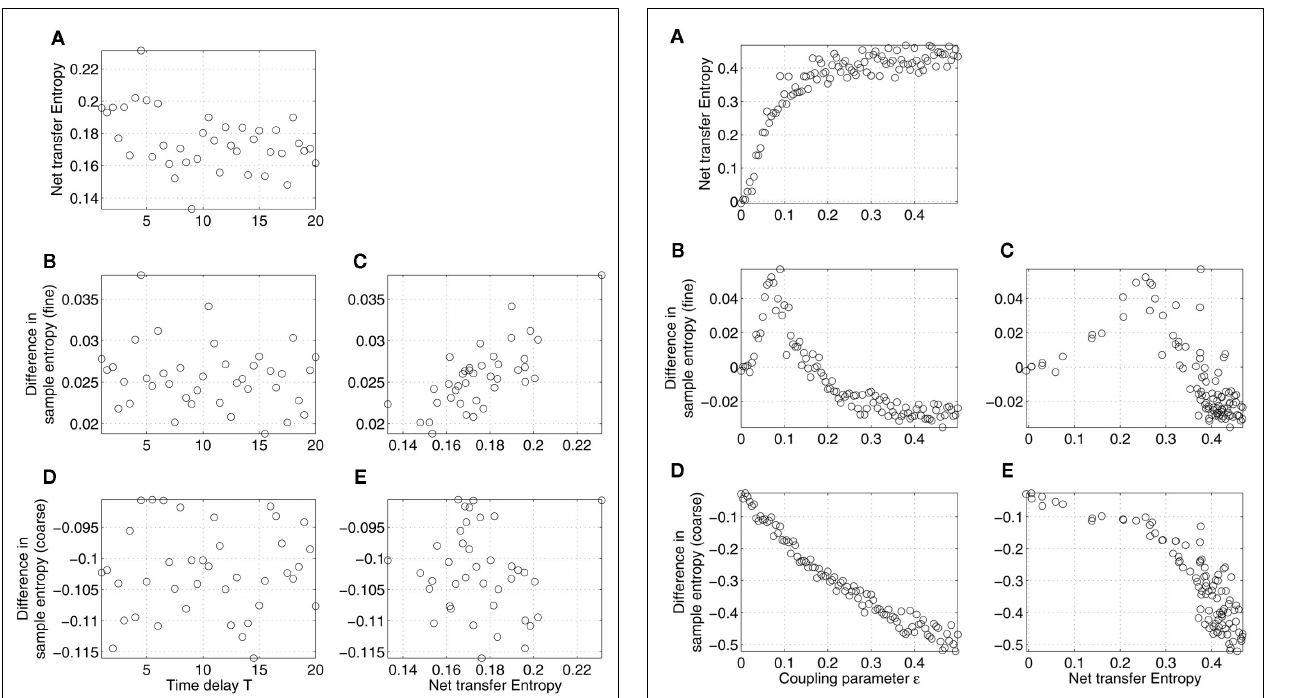
FIGURE 5 | Effects of time delay in coupling on the relations between differences in sample entropy between coupled Rössler’s oscillators and net information transfer between them. Specifically, net transfer entropy (A) and differences in sample entropy computed at fine (B) and coarse (D) time scales are plotted as functions of the time delayT in coupling. Sample entropy and transfer entropy were estimated based on the time series x 1 and x 2 , generated according to the model (12) for the different values of the parameter T with a contant ∈ . Only the relations illustrated in (C,E) can be observed in the MEG data analysis ( Figure 2 ). Specifically, (C) (correlation r = 0.73, p -value < 0.0001) corresponds to Figure 2A , whereas (E) (correlation r =− 0.08, statistically not different from 0) corresponds to Figure 2B .